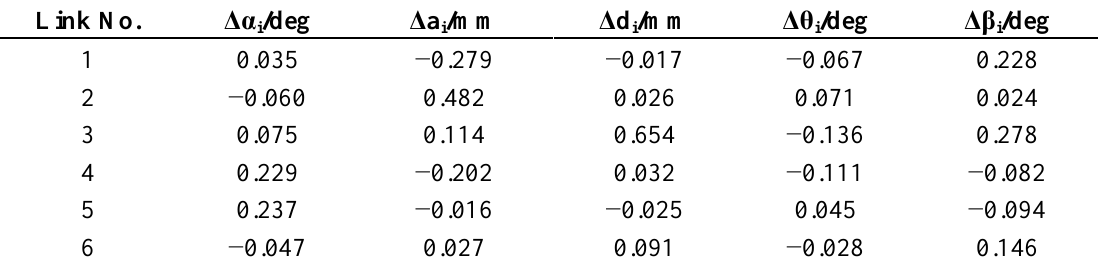
Table 2. Identified values for kinematic parameters